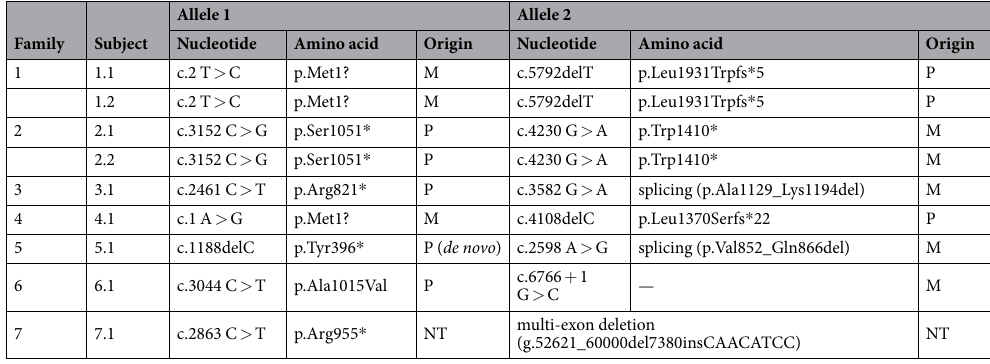
Table 2. Mutations identified in the nine Vici syndrome patients. The numbering of the mutations and alterations is relative to NM_020964.2 (gene) and NP_066015.2 (protein), respectively. With regard to multi-exon deletions, the variant’s description is relative to genomic sequence records for NG_042838.1. Synonymous mutations in patient 3.1 and patient 5.1 were found to cause an in-frame deletion on the basis of cDNA sequence data derived from affected individuals. ?protein has not been analysed, an effect is expected but difficult to predict, * = the protein coding sequence ends at a translation termination codon, P = paternal, M = maternal, NT = not